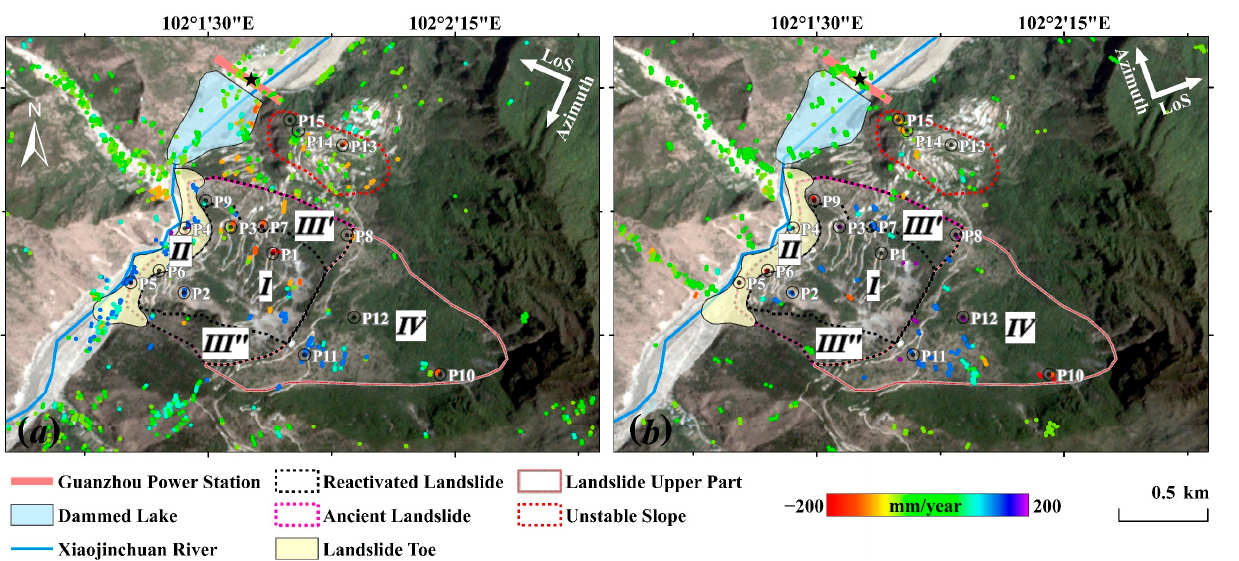
Figure 4. Post-failure LoS deformation mean velocity detected from the Sentinel-1 ( a ) descending and ( b ) ascending datasets. The black star represents the reference point, and the black circles represent the selected measurement points.